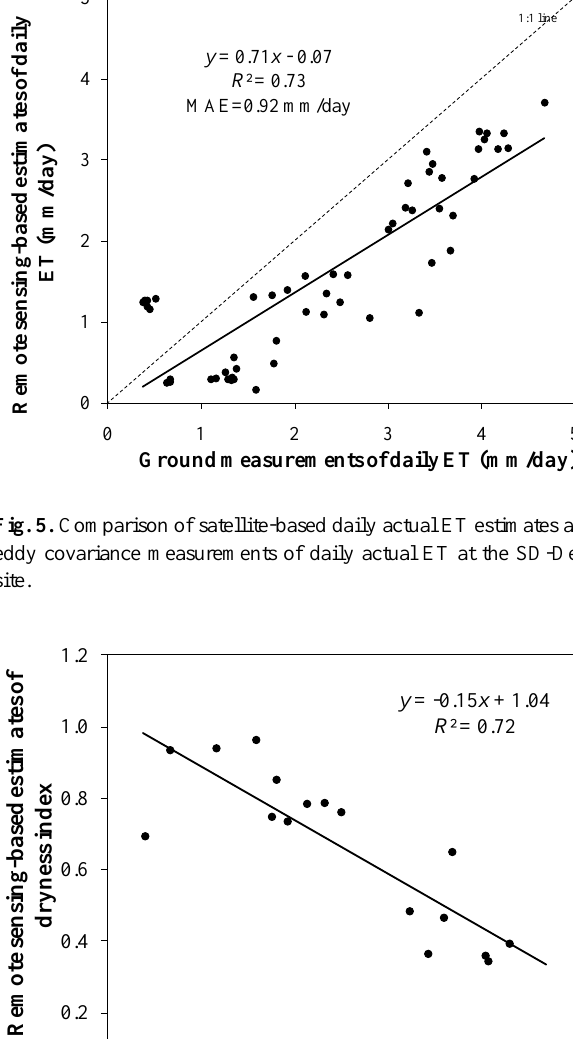
Fig. 6. Satellite-based daily dryness index estimates versus eddy Fig. 6 . Satellite-based daily dryness index estimates versus eddy covariance covariance measurements of daily actual ET at the SD-Dem measurements of daily actual ET at the SD-Dem site.